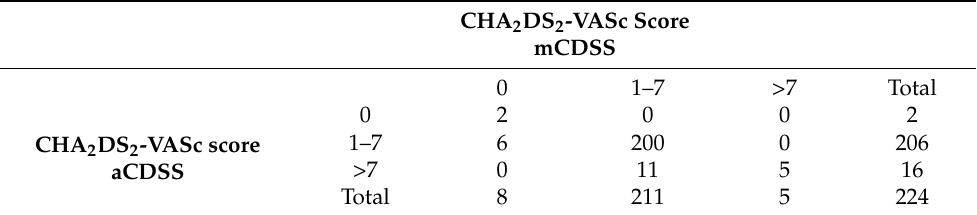
Table 1. CHA 2 DS 2 -VASc aCDSS/mCDSS cross tabulation. Range CHA 2 DS 2 -VASc. score 0–10.